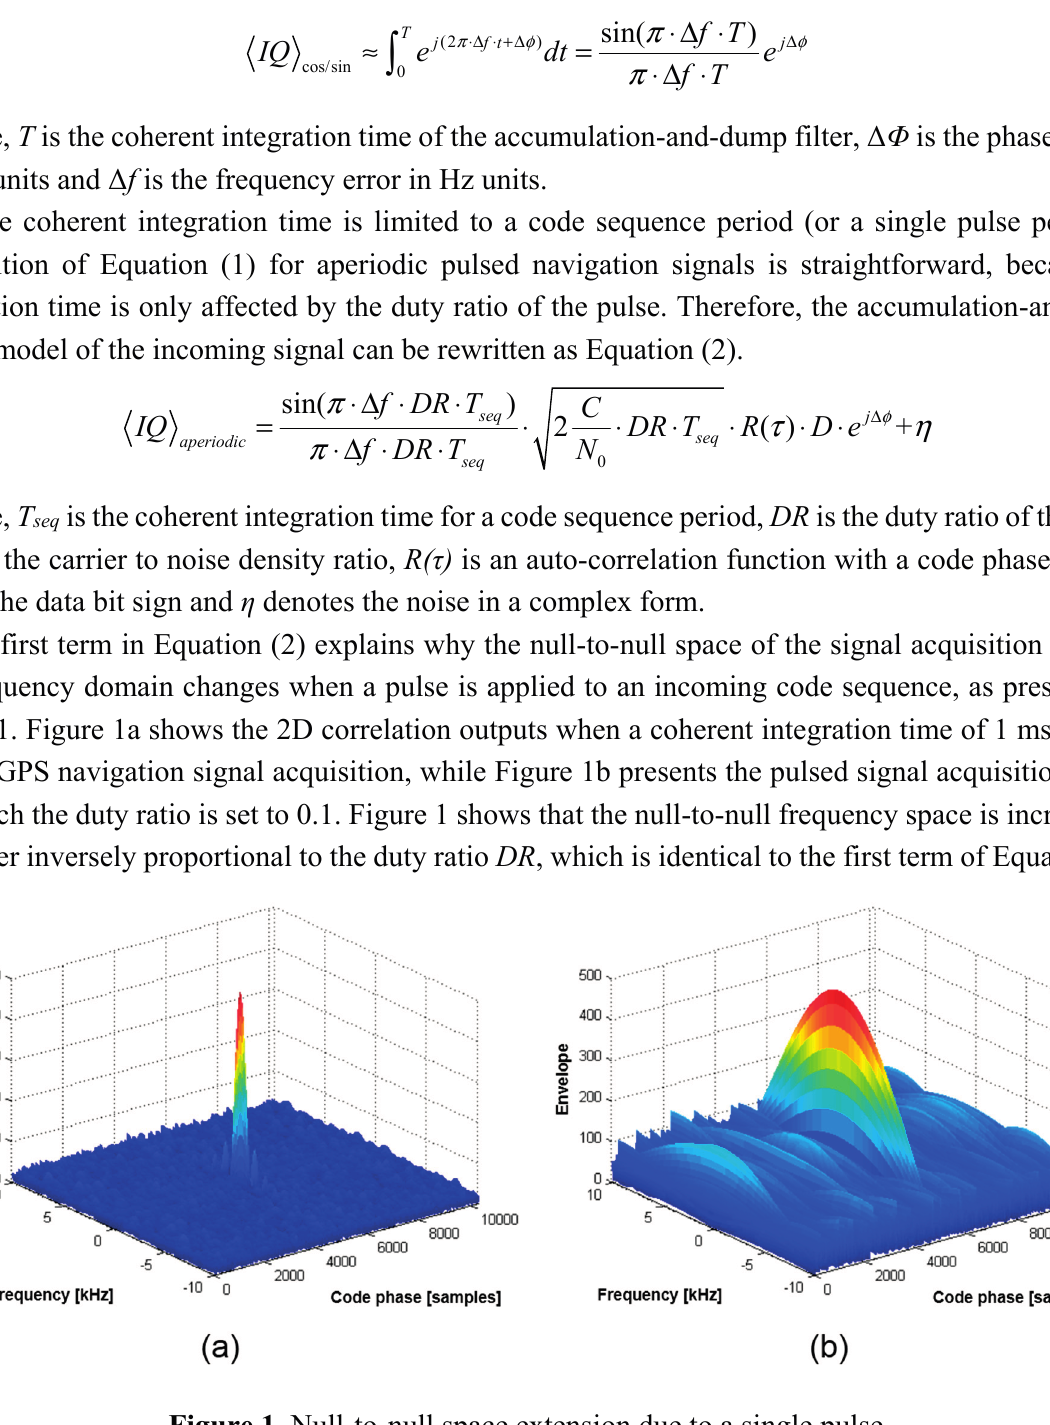
Figure 1. Null-to-null space extension due to a single